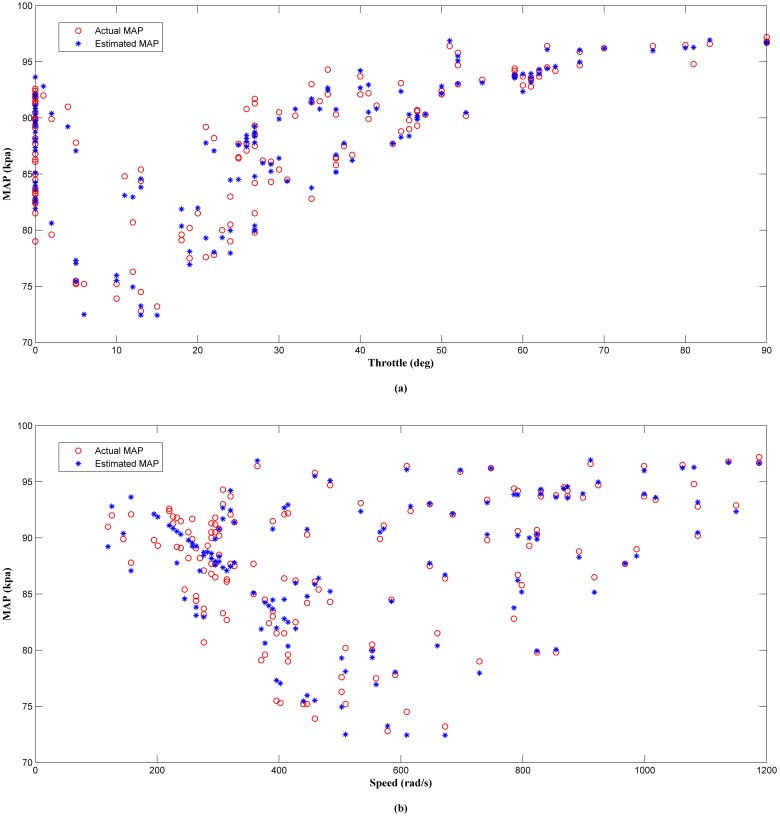
Comparison of the MAP estimator output (LM+BR+PSOb) and actual MAP as function of (a) throttle and (b) speed.